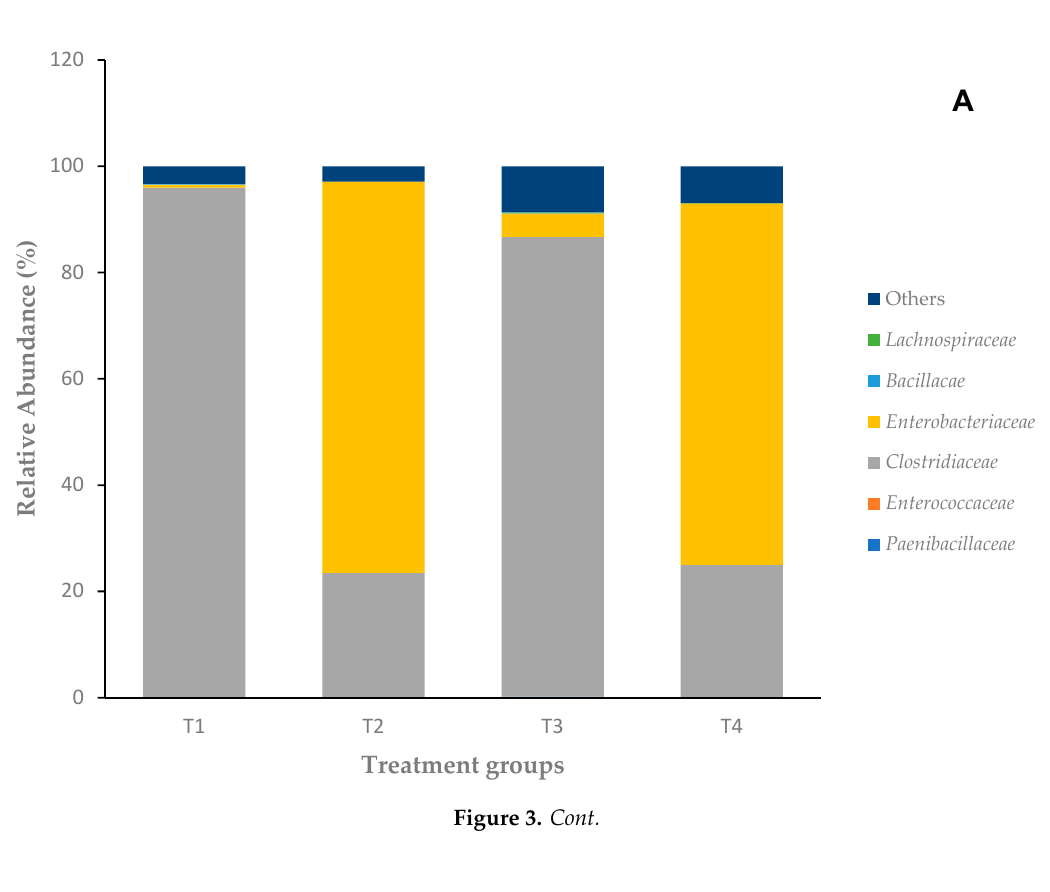
Figure 3. ( A ) Microbiota composition of day 2 chicken ceca; ( B ) microbiota composition of day 4 chicken ceca.